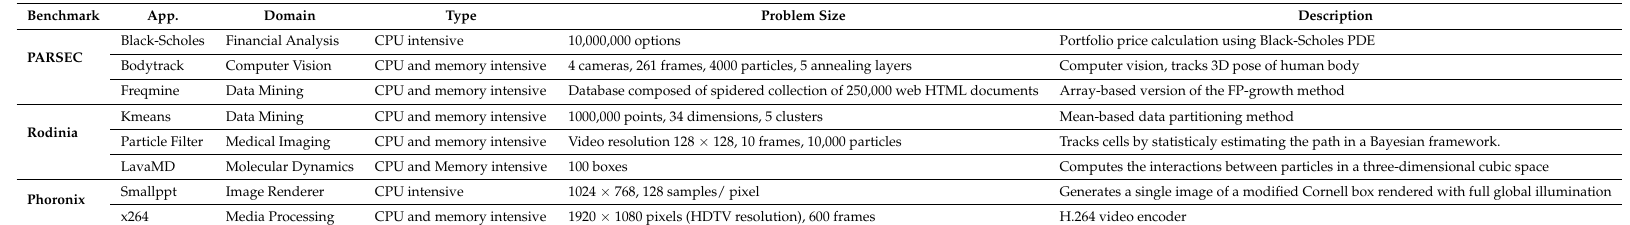
Table 2. Characteristics detail of each application based on